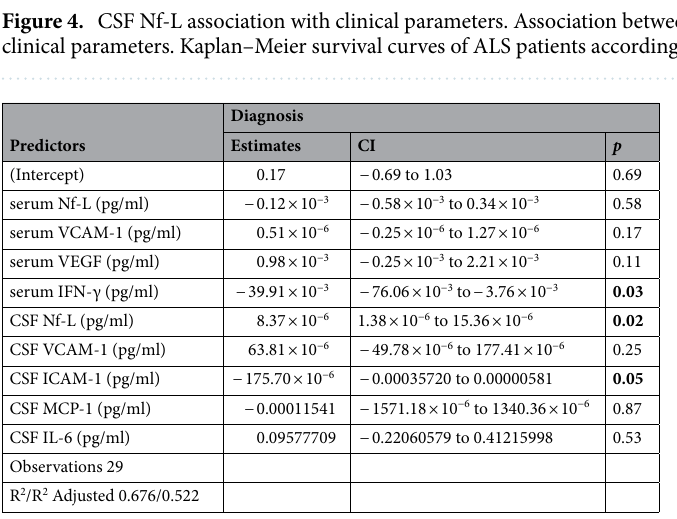
Table 3. Predictive values of the biomarkers on diagnosis by logistic regression analysis. Significant p values are indicated in bold.